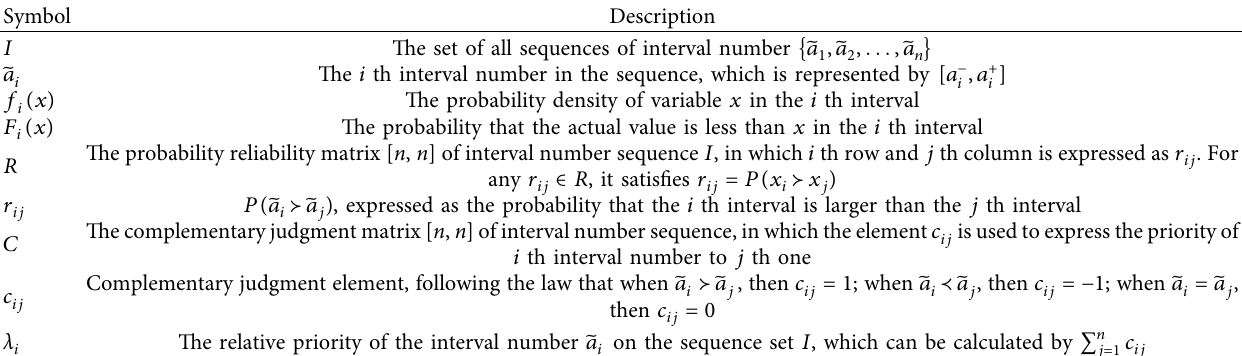
Table 1: Notations in the interval number ranking problem.